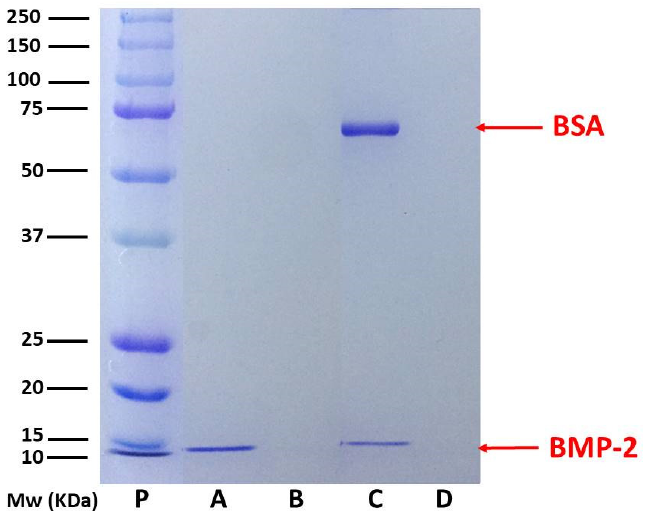
Figure 1. SDS polyacrylamide gel electrophoresis (SDS-PAGE) analysis under reducing conditions of solid PLGA Nanoparticles (PLGA NPs) and liquid (supernatant) fractions of different NP systems. Lane P : Protein standards; lane A : NP-BMP2 (bone morphogenetic protein); lane B : supernatant of NP-BMP2 after synthesis and encapsulation of rhBMP-2; lane C : NP after physical adsorption of BSA/rhBMP-2; lane D : supernatant after physical adsorption of BSA(bovine serum albumin)/rhBMP- 2 on NP system.